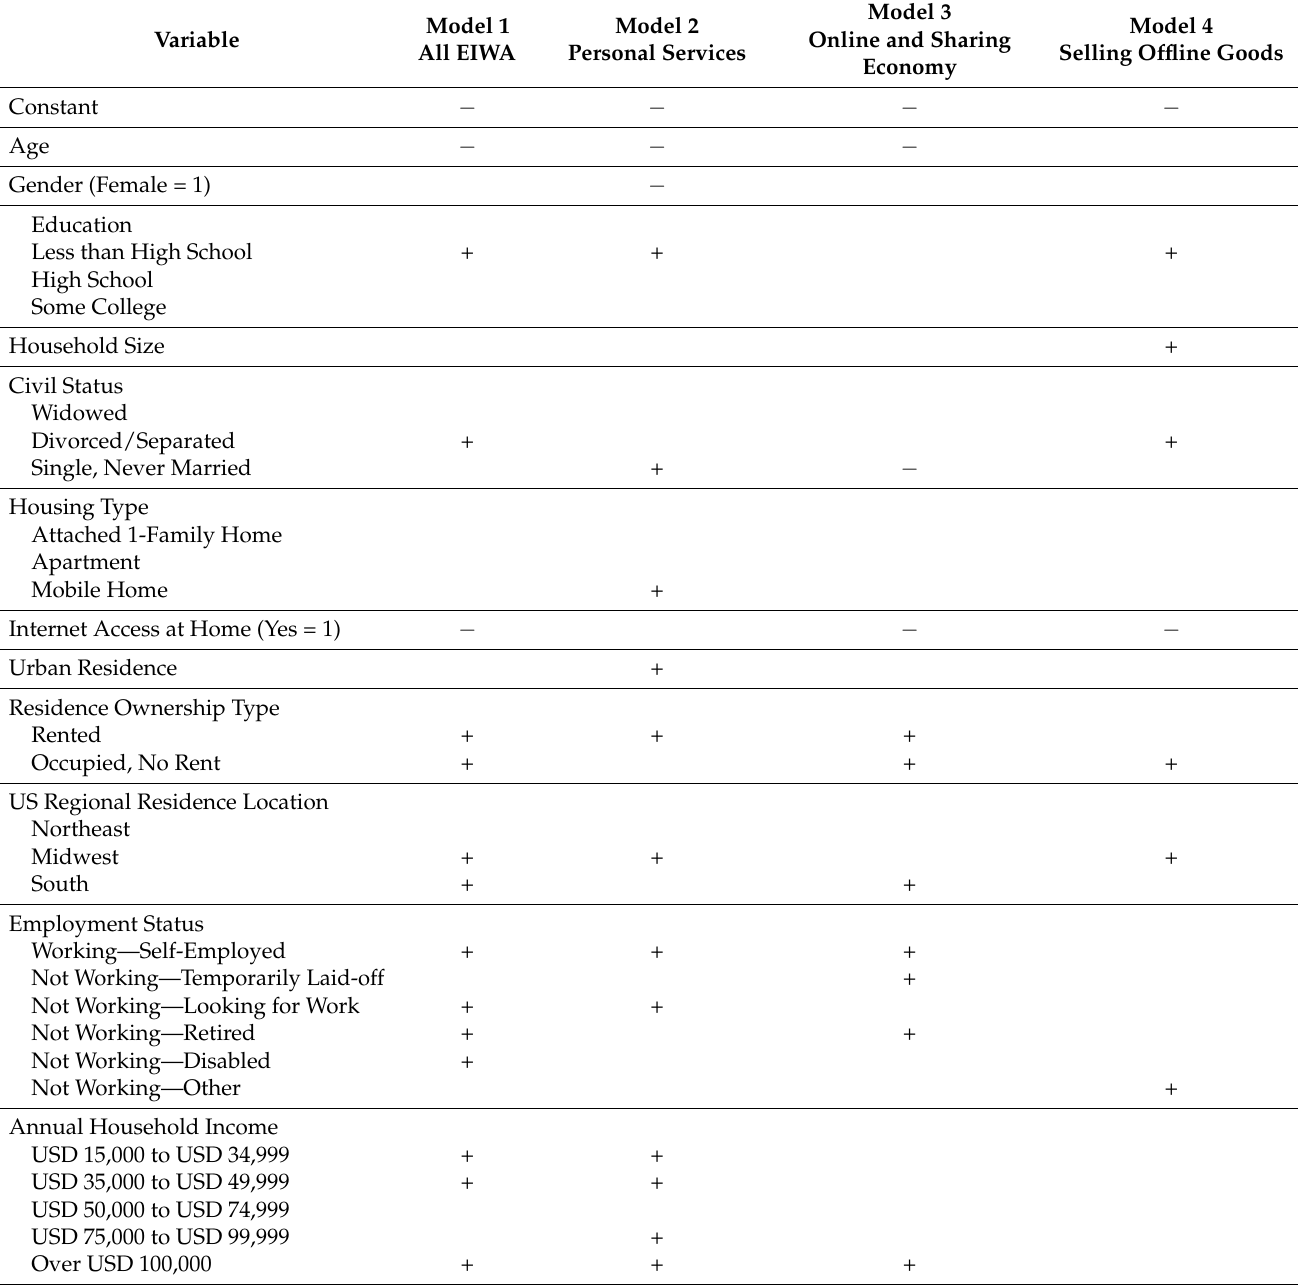
Table 12. Logistic Regression of Hispanic EIWA (EIWA Participants = 1)—Summary